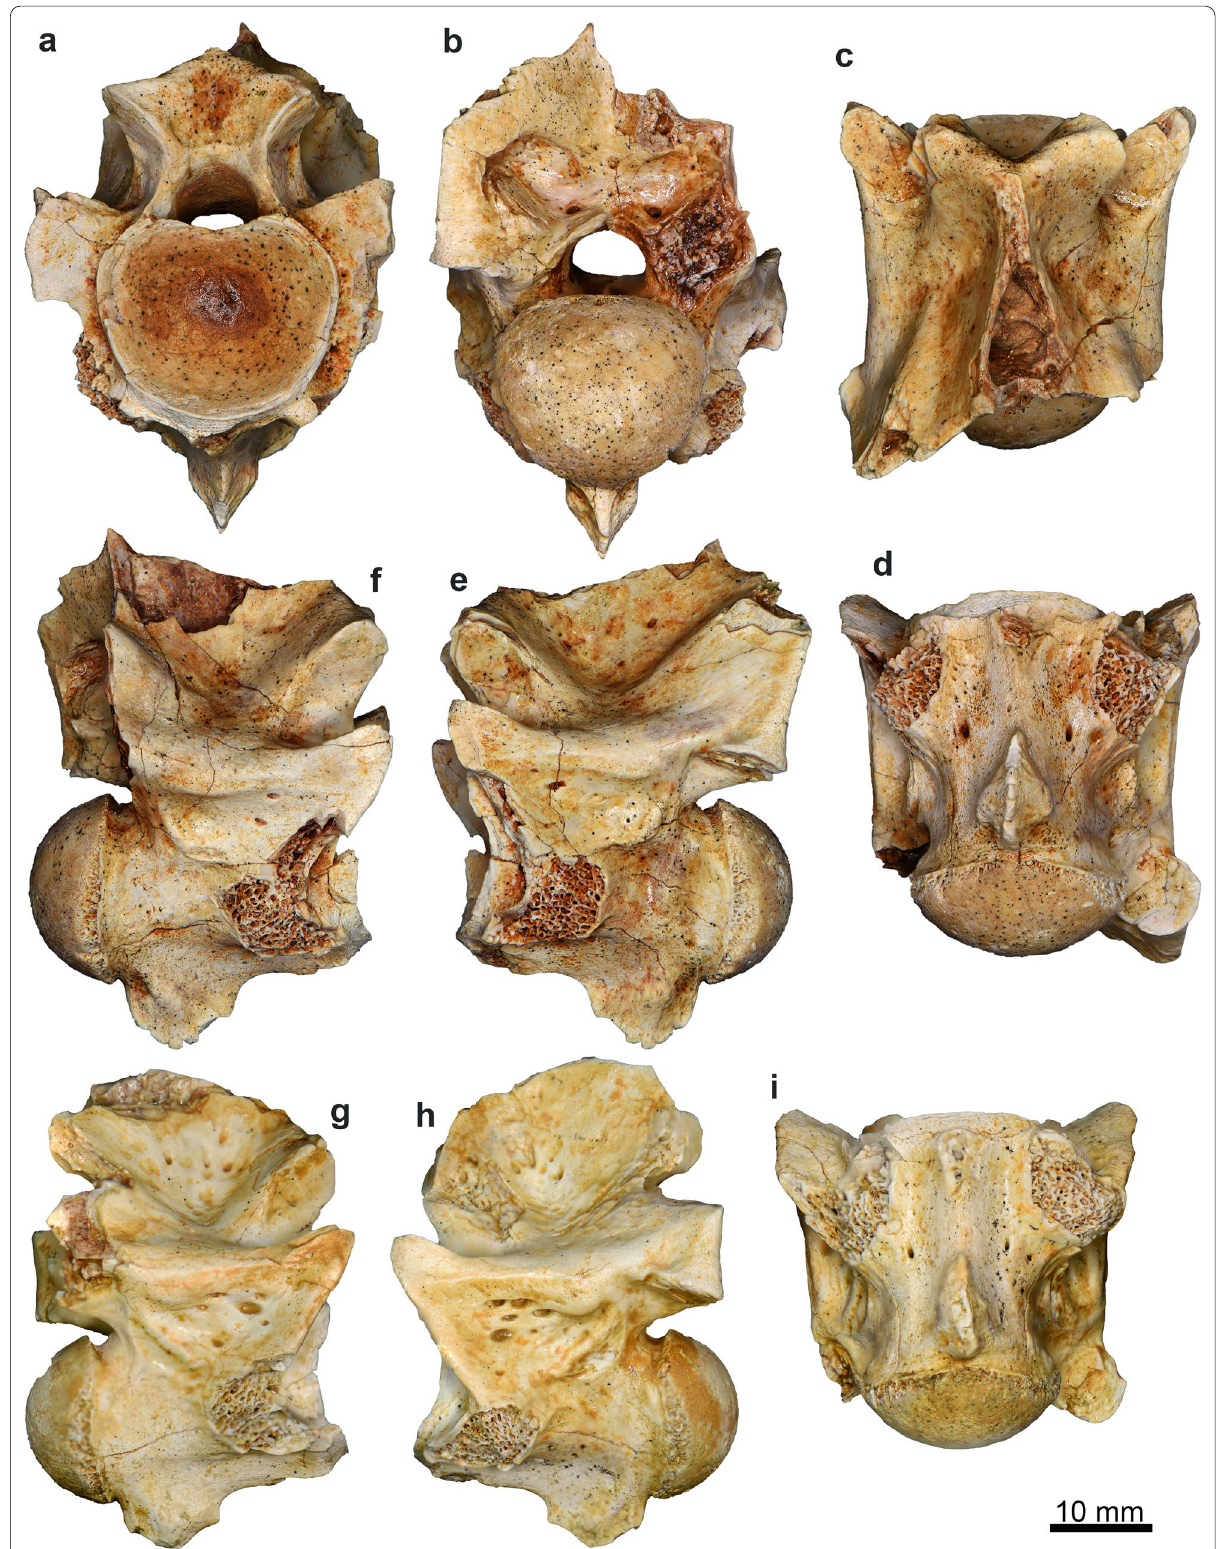
Fig. 8 a–f Mid-trunk vertebra UM KPO 30 in anterior ( a ), posterior ( b ), dorsal ( c ), ventral ( d ), left lateral ( e ), and right lateral ( f ) views; g–i mid-trunk vertebra UM KPO 21 in right lateral ( g ), left lateral ( h ), and ventral ( i )